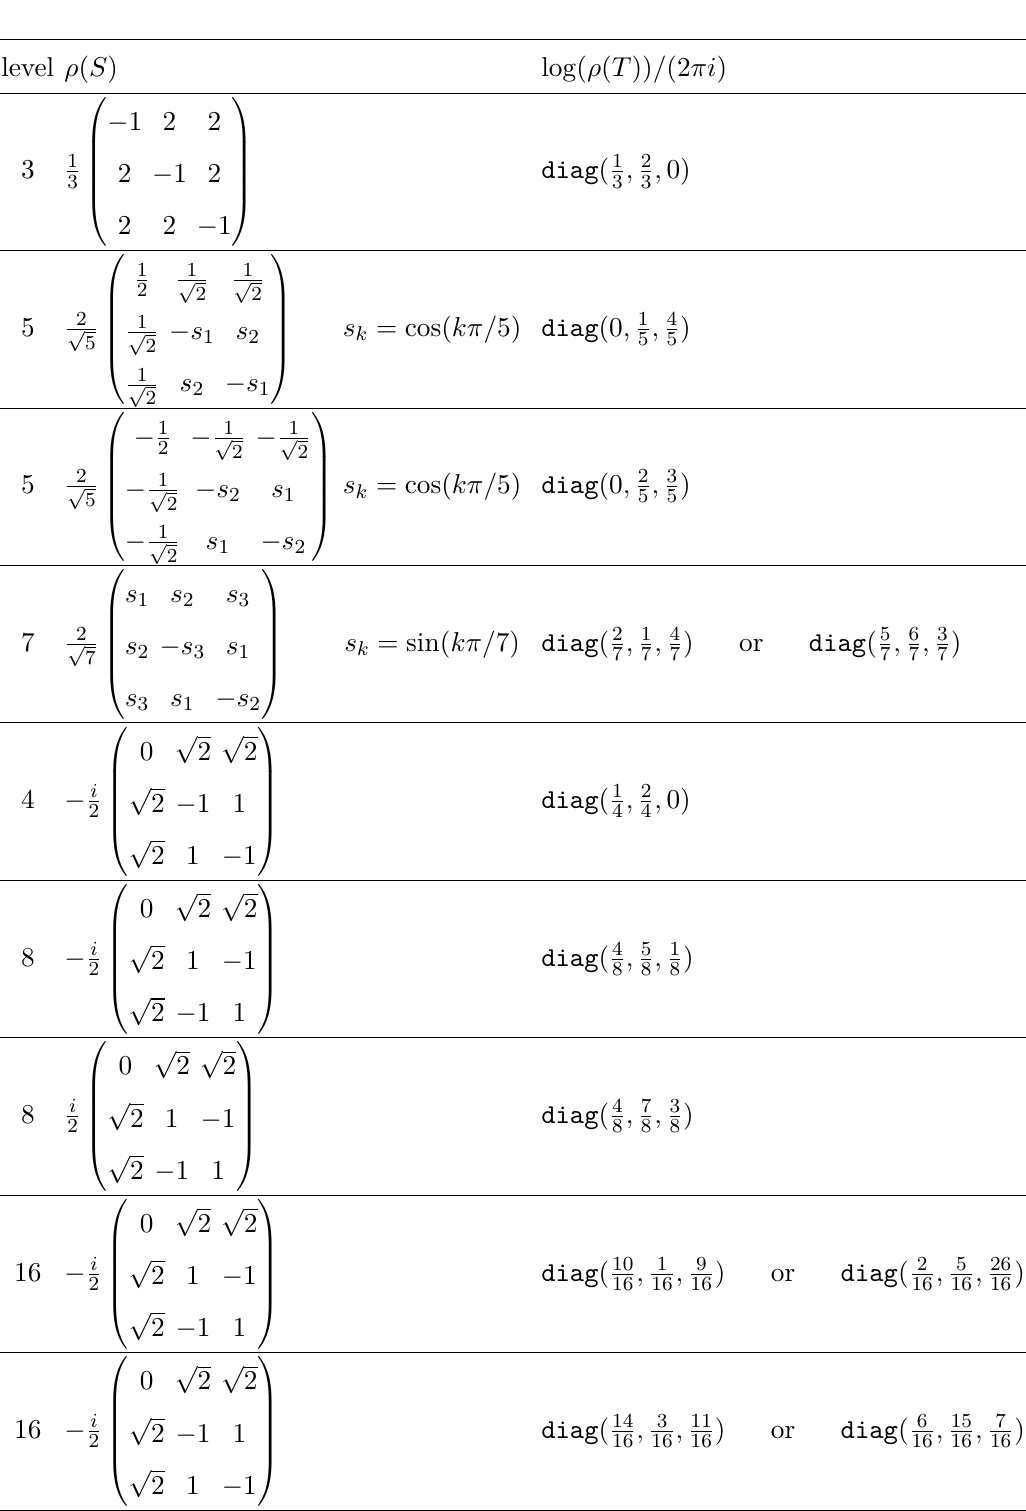
Table 8 . Three-dimensional irreducible representations of SL(2 , Z N ) . To obtain the full set of independent representations at level N = 4 , 8 , 16 , we should multiply each of those listed here by the four one-dimensional representations given in table